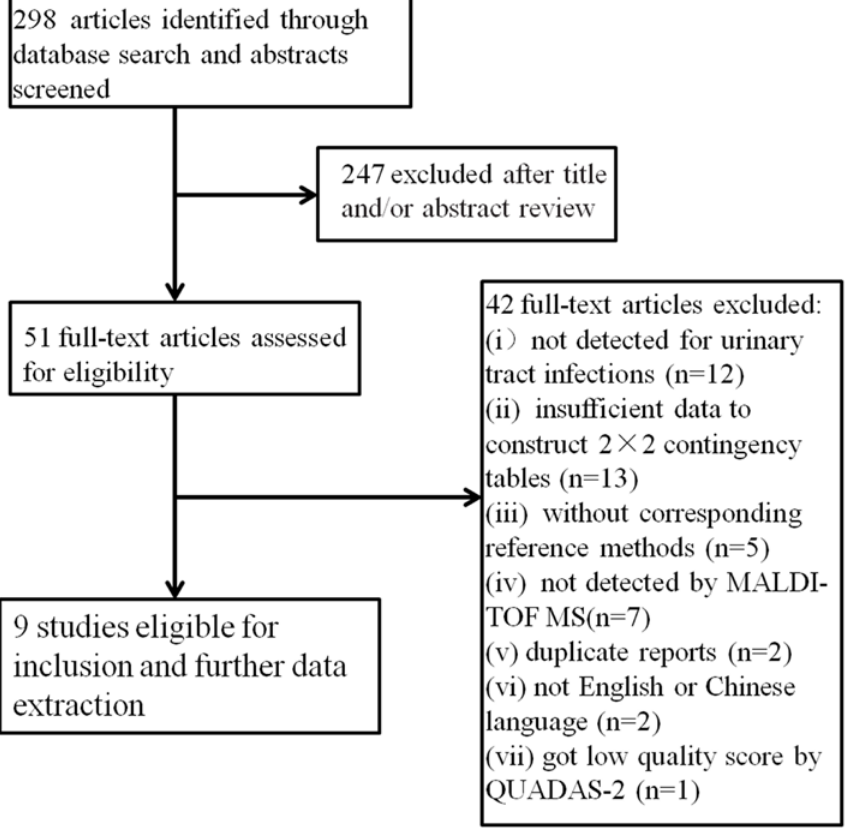
Figure 1: Flowchart describing the systematic literature search and study selection process for the